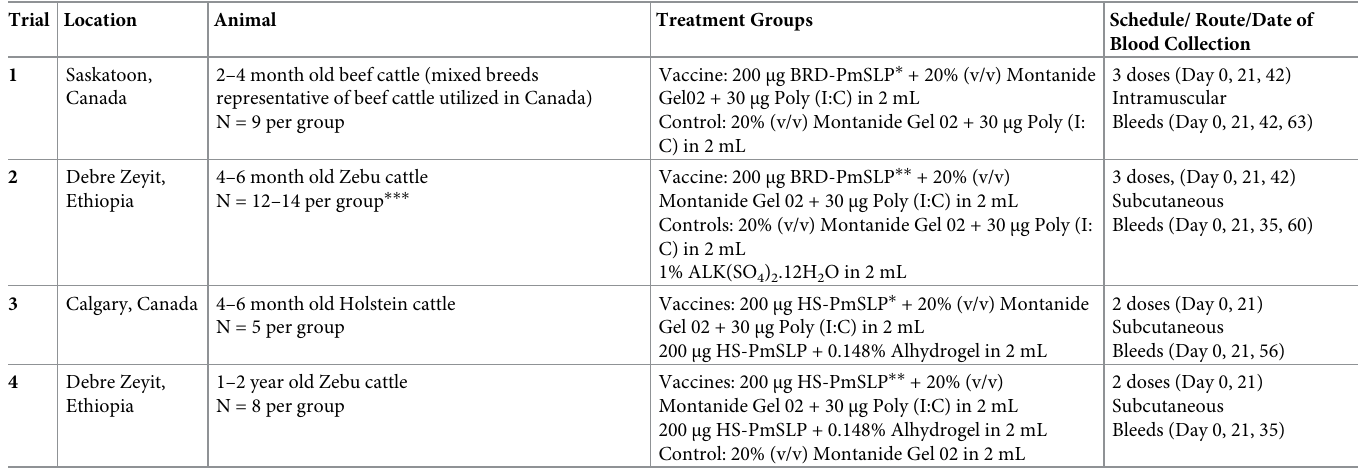
Table 2. Experimental layout of PmSLP cattle